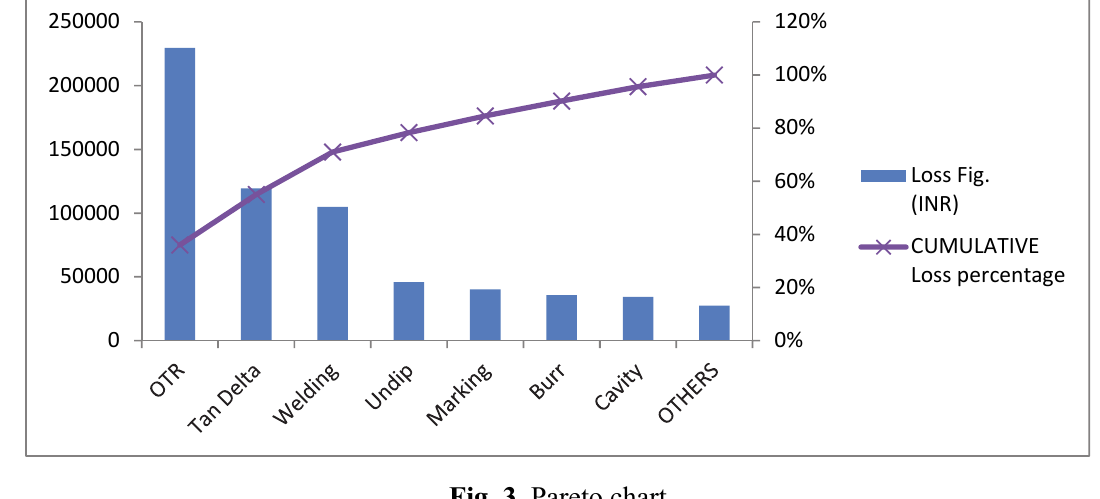
The solution Root Weight Cause age